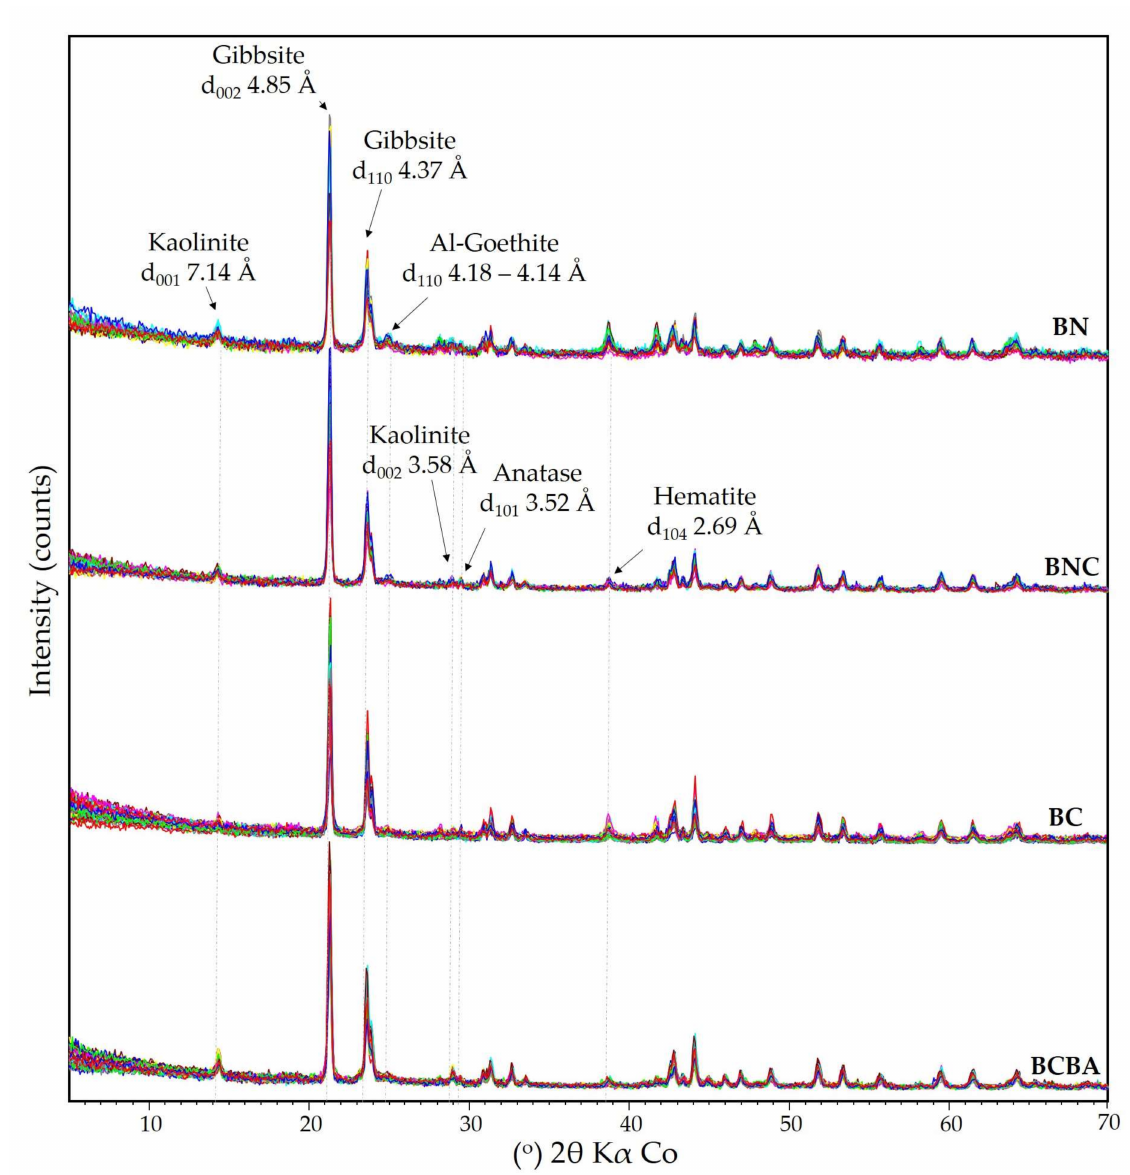
Figure 2. XRD patterns of the bauxite samples from BN, BNC, BC and BCBA